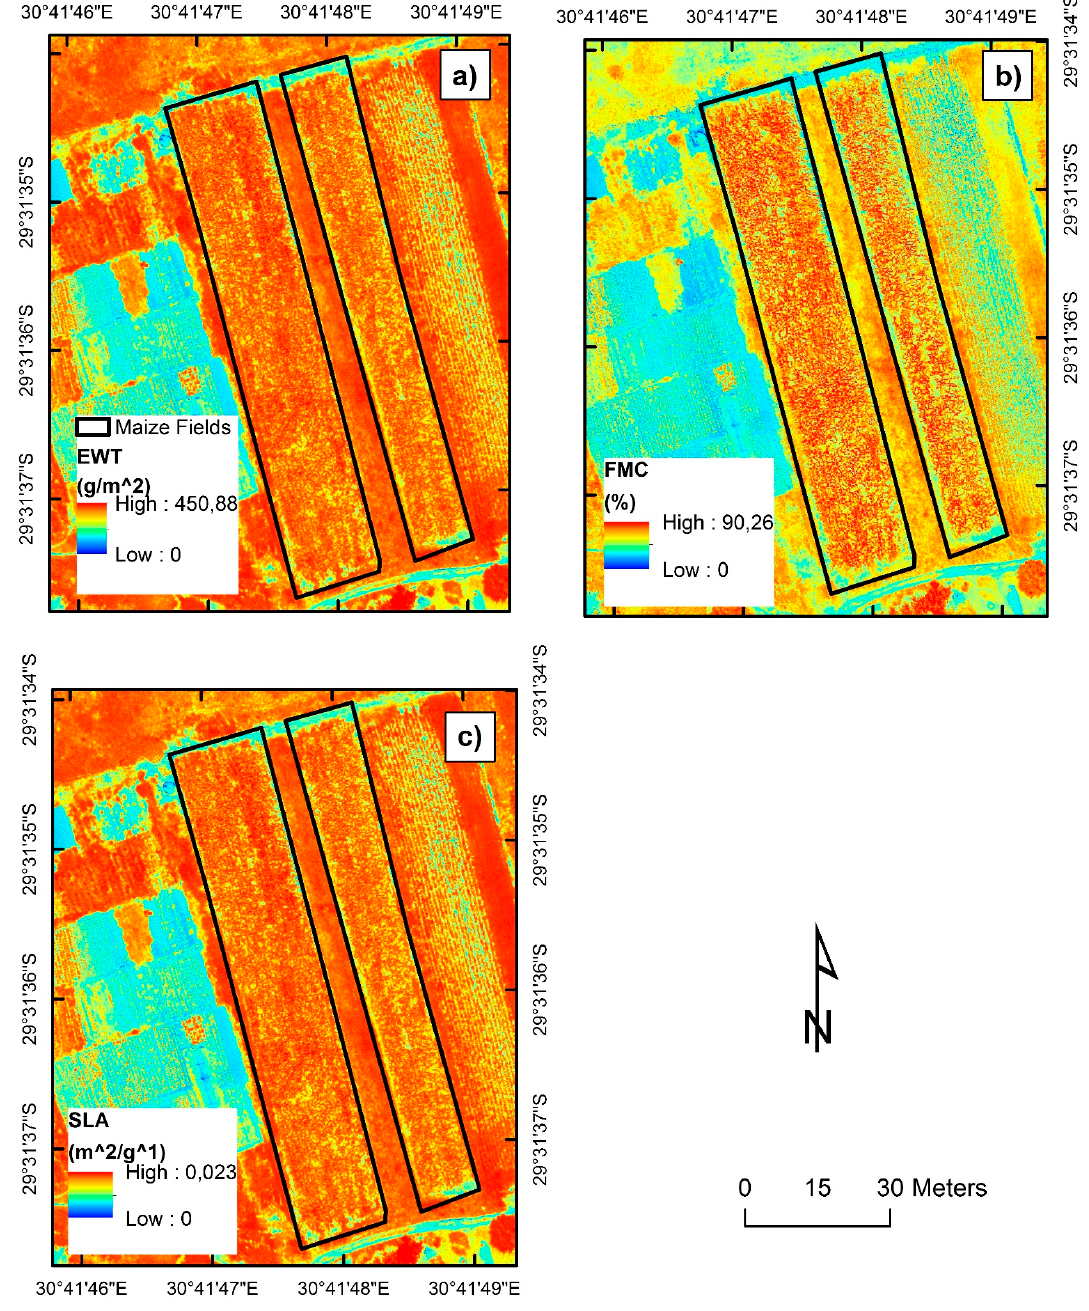
Figure 4. Spatial distribution of ( a ) EWT leaf , ( b ) FMC leaf , and ( c ) SLA leaf of smallholder maize crops.